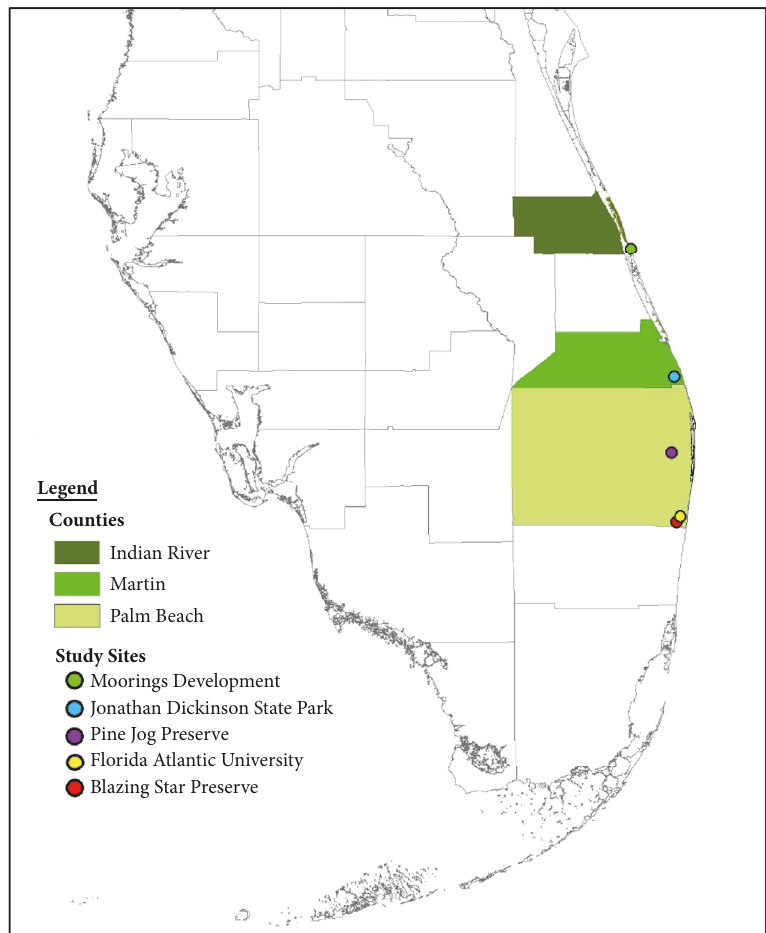
Figure 1: Locations of the five study sites in Florida, USA, from which the six gopher tortoise populations were sampled. Jonathan Dickinson State Park contained two of the study populations, one in Pineland and the other in